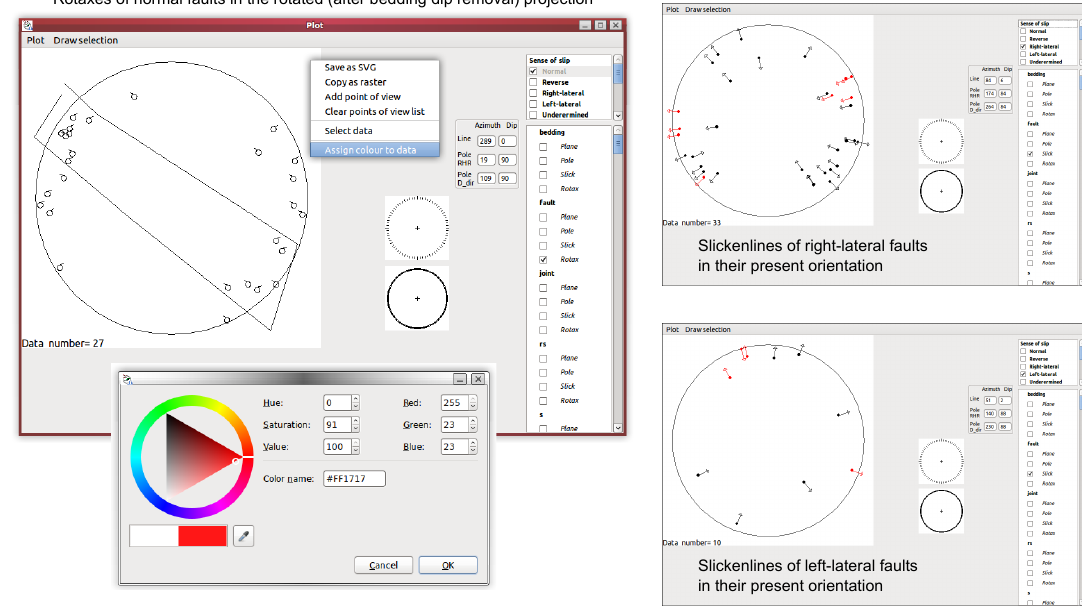
Fig. 9. Procedure for assigning a colour to elements according to their orientation. In this example a red colour is assigned to faults that are normal in the rotated analysis and have rotaxes striking WNW-ESE. The projection of data in their present orientation (plots on the right) indicates that many strike-slip faults are tilted normal faults.